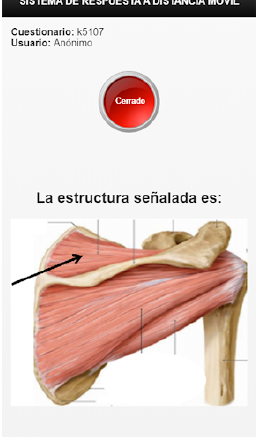
Figure 2. Example of Question Formulated in the G-SIDRA (Gamified Immediate Audience Response System) Mobile Interface.